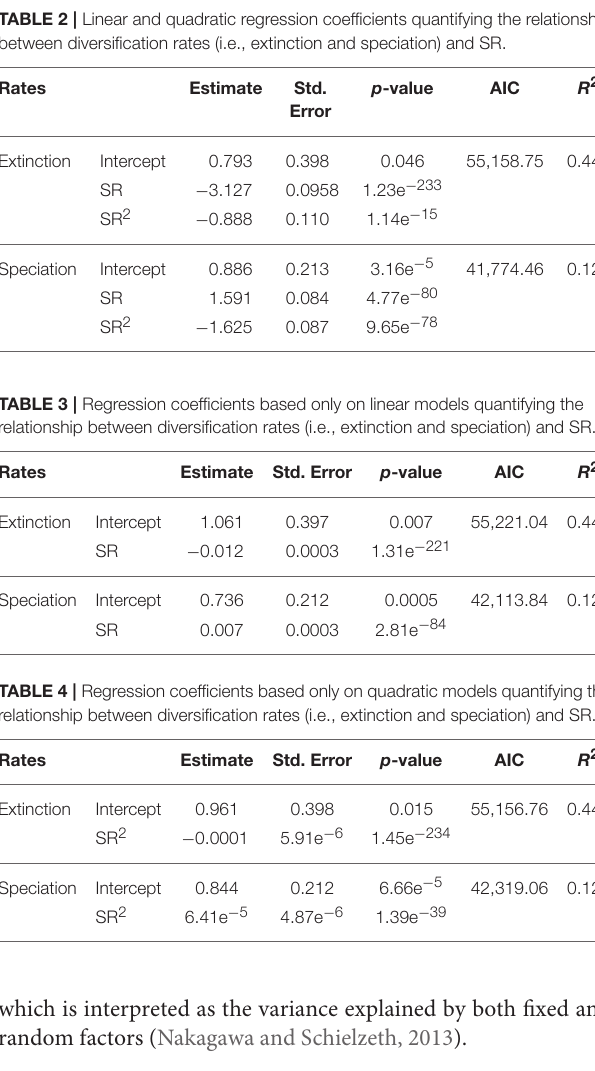
TABLE 2 | Linear and quadratic regression coefficients quantifying the relationship between diversification rates (i.e., extinction and speciation) and SR. p -value R 2 Rates Estimate Std. Error